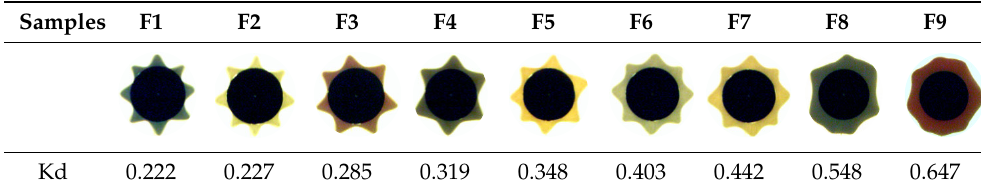
Figure 3. The process of fabric drape computer simulation in the Optitex CAD system: ( a ) creation of a planar circular sample of given dimensions; ( b ) a solid disk model of specified dimensions; ( c ) positioning of the planar circular sample above the disk model; ( d ) computer simulation of fabric drape.